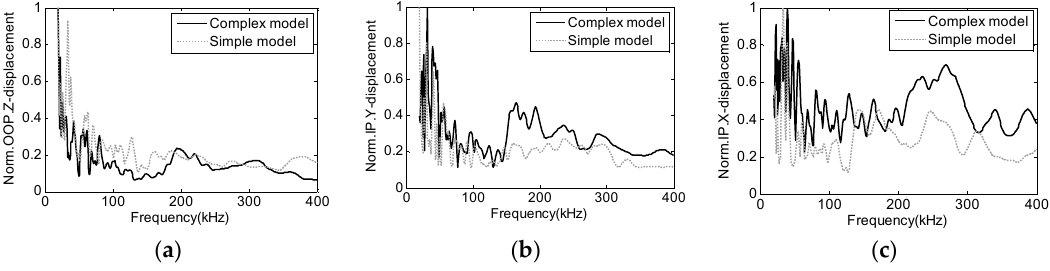
Figure 4. The comparison of displacement responses in frequency domain, ( a ) z direction; ( b ) y direction; and ( c ) x direction.